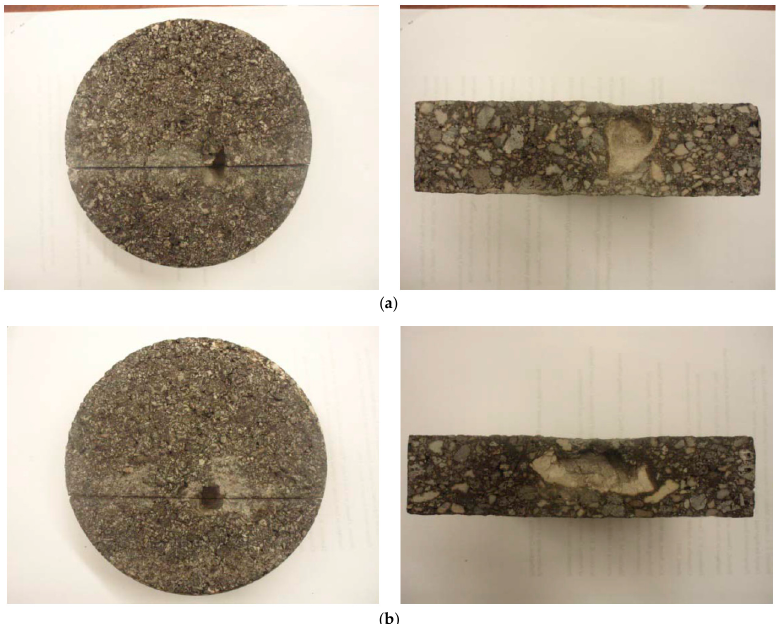
Figure 6. Clay balls with ( a ) one inch in diameter and ( b ) two inches in diameter.